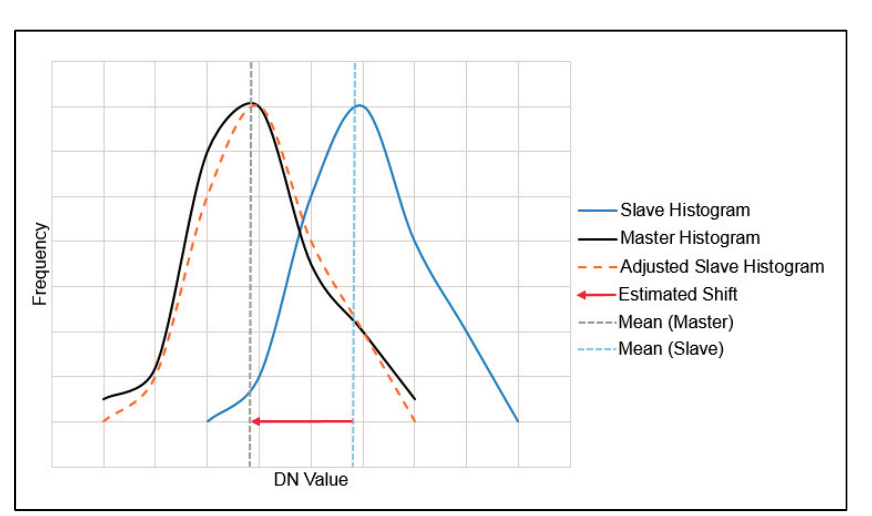
Figure 2. A hypothetical example of radiometric normalization using the histogram matching technique. DN (digital